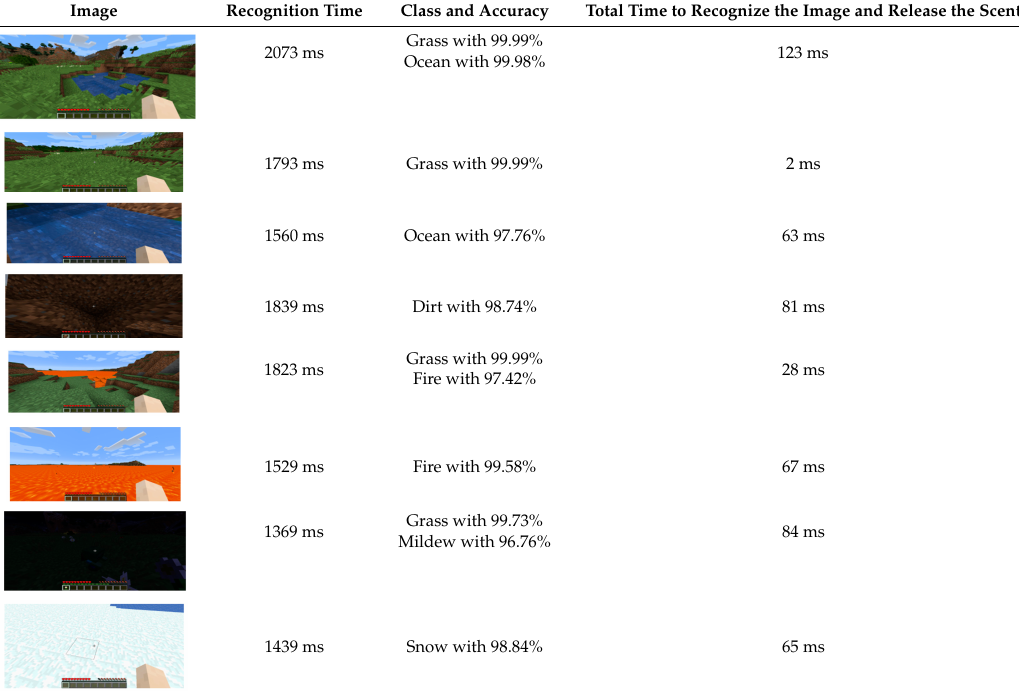
Table 4. Performance of the model within the